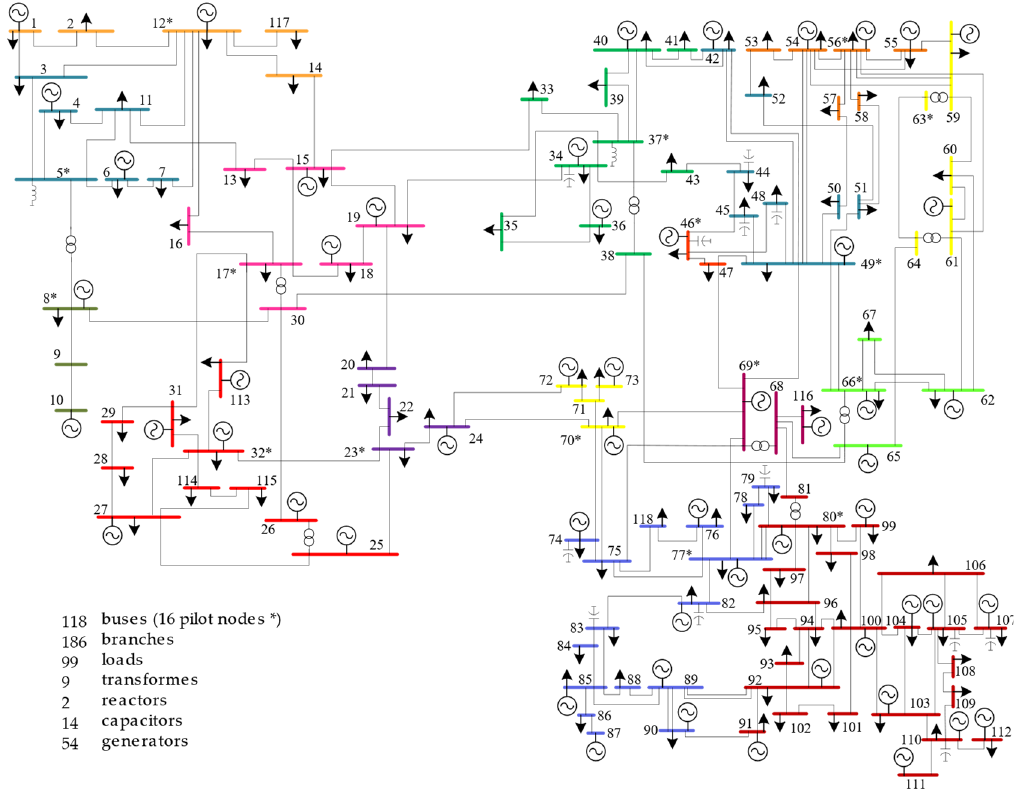
Figure 3. Single-line diagram of the IEEE118-bus test system with pilot nodes and voltage control areas.